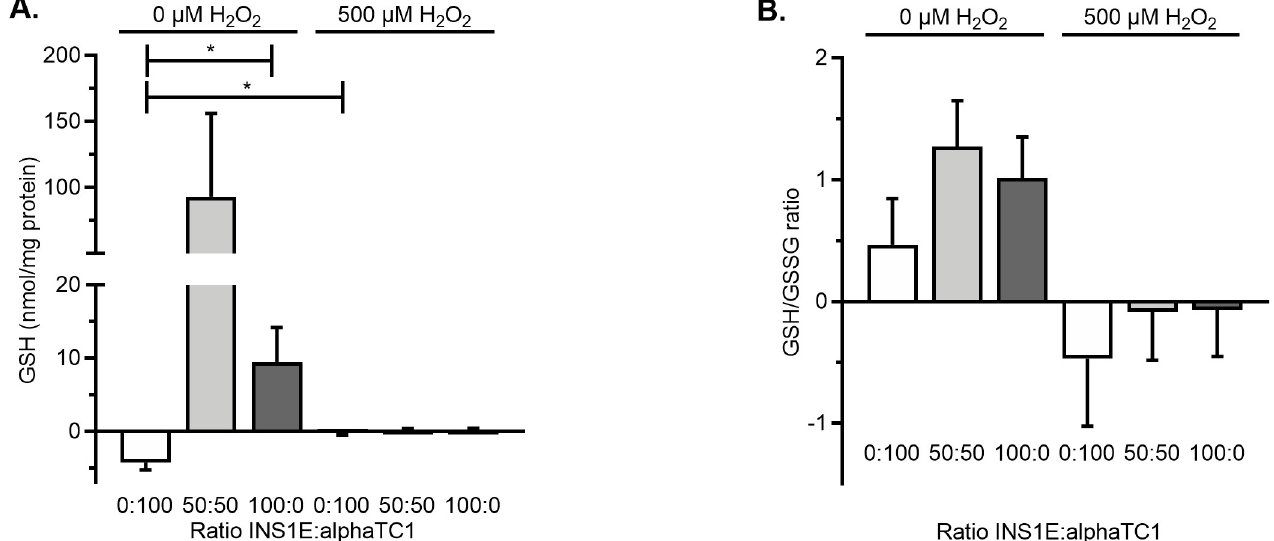
Fig 5. Intracellular GSH and GSH/GSSG ratio in 3D aggregates upon induced oxidative stress. A) The intracellular GSH in 3D aggregate of INS1E cells alone was significantly lower than in alphaTC1 cells alone. Exposing the 3D aggregates to 500 μ M H 2 O 2 only significantly affected the intracellular GSH in the ratio 0:100 INS1E:alphaTC1. B) GSH/GSSG ratio in 3D aggregates of 0:100, 50:50 and 100:0 INS1E:alphaTC1 cells exposed to 0 and 500 μ M H 2 O 2 showed a similar trend. N = 3, n = 2 and data are presented as mean ± SEM; � p � 0.05, all p-values are shown in S10 Table.